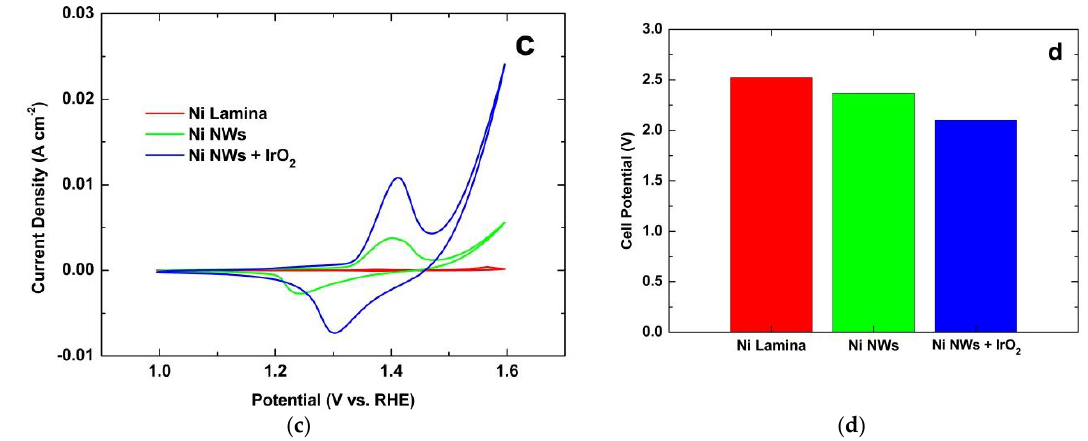
Figure 5. ( a ) XRD diffraction patterns of Ni NWs without and with iridium oxide electrocatalyst; ( b ) SEM image of functionalized Ni NWs; ( c ) CV and ( d ) cell potential of Ni NWs without and with iridium oxide electrocatalyst. For comparison, the behavior of the Ni sheet was reported as well.